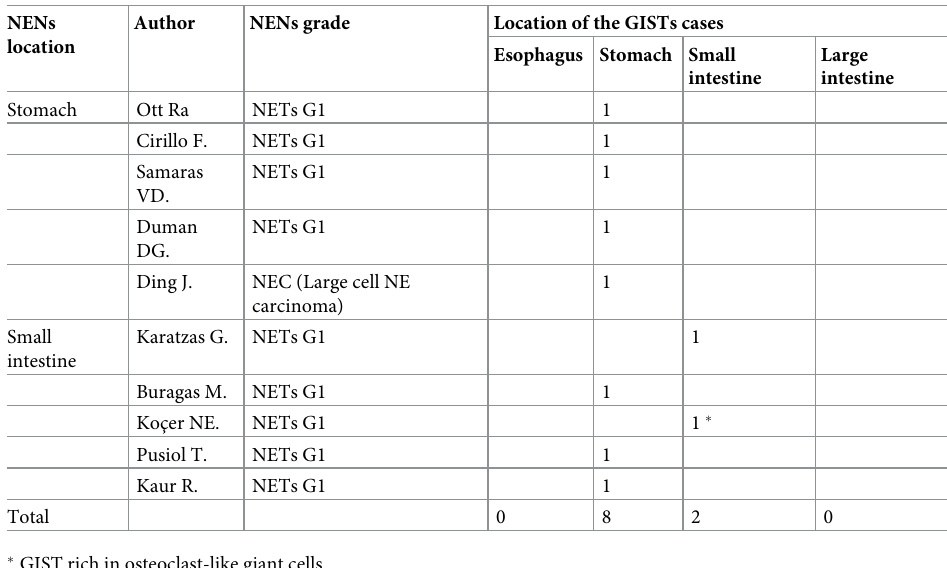
Table 4. Characteristics of the GISTs